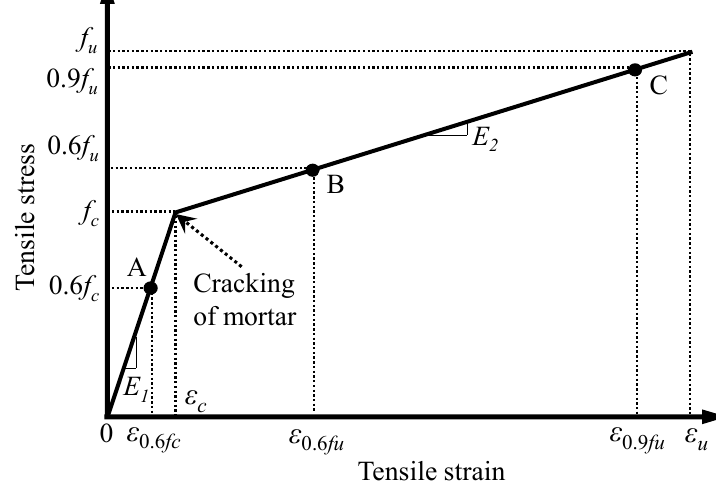
Figure 11. Idealized stress–strain curve of the TRM coupons [33].